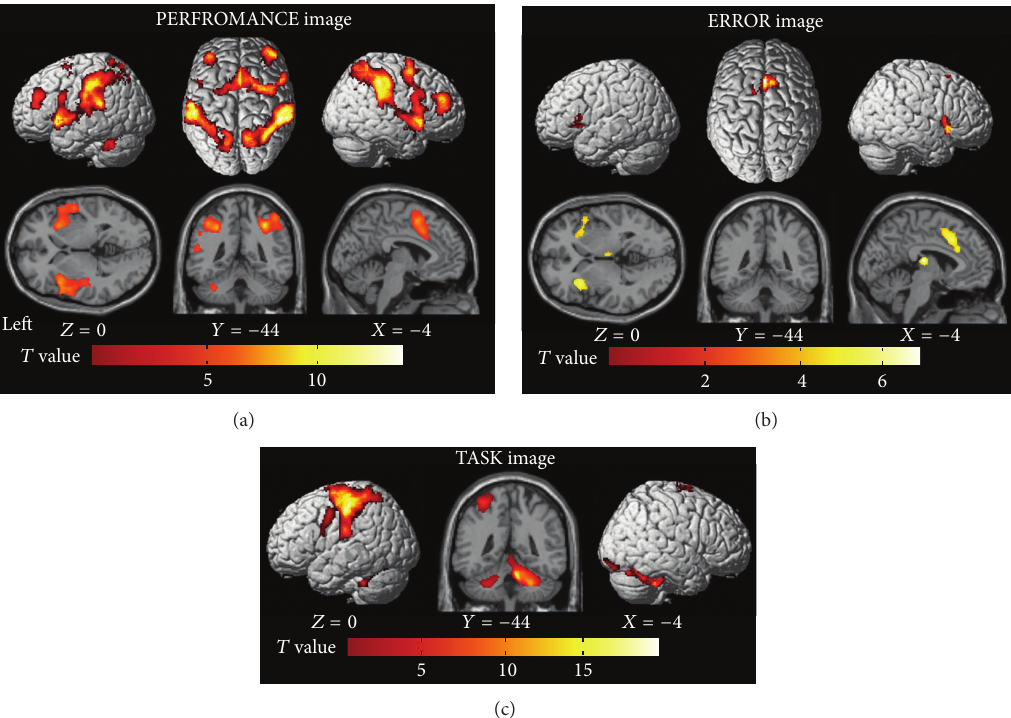
Figure 3: (a) Brain regions where activity was negatively correlated with the number of correct sequences (PERFROMANCE image). (b) Brain regions where activity was related to the occurrence of movement errors (ERROR image). (c) Brain regions active during the 10s execution period (TASK image). Activities are superimposed on the MNI standard